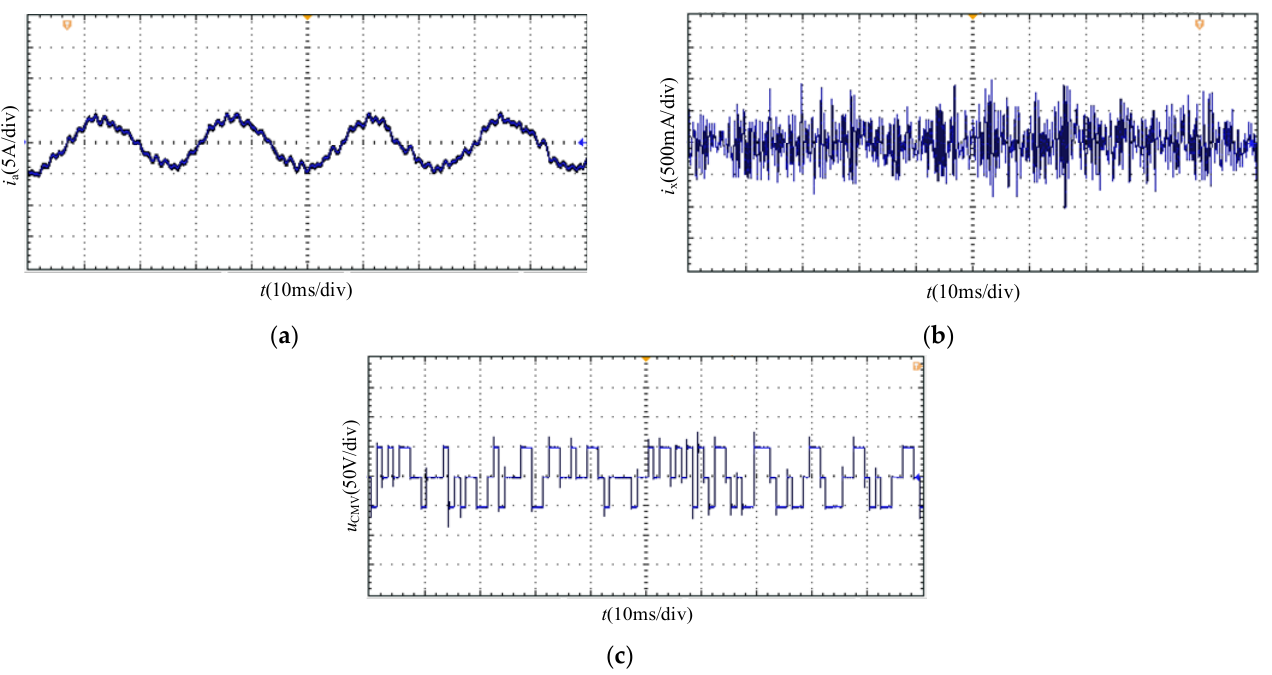
Figure 16. Steady experimental waveforms of MPTC1: ( a ) a-phase stator current; ( b ) harmonic current component i x ; ( c ) common-mode voltage.